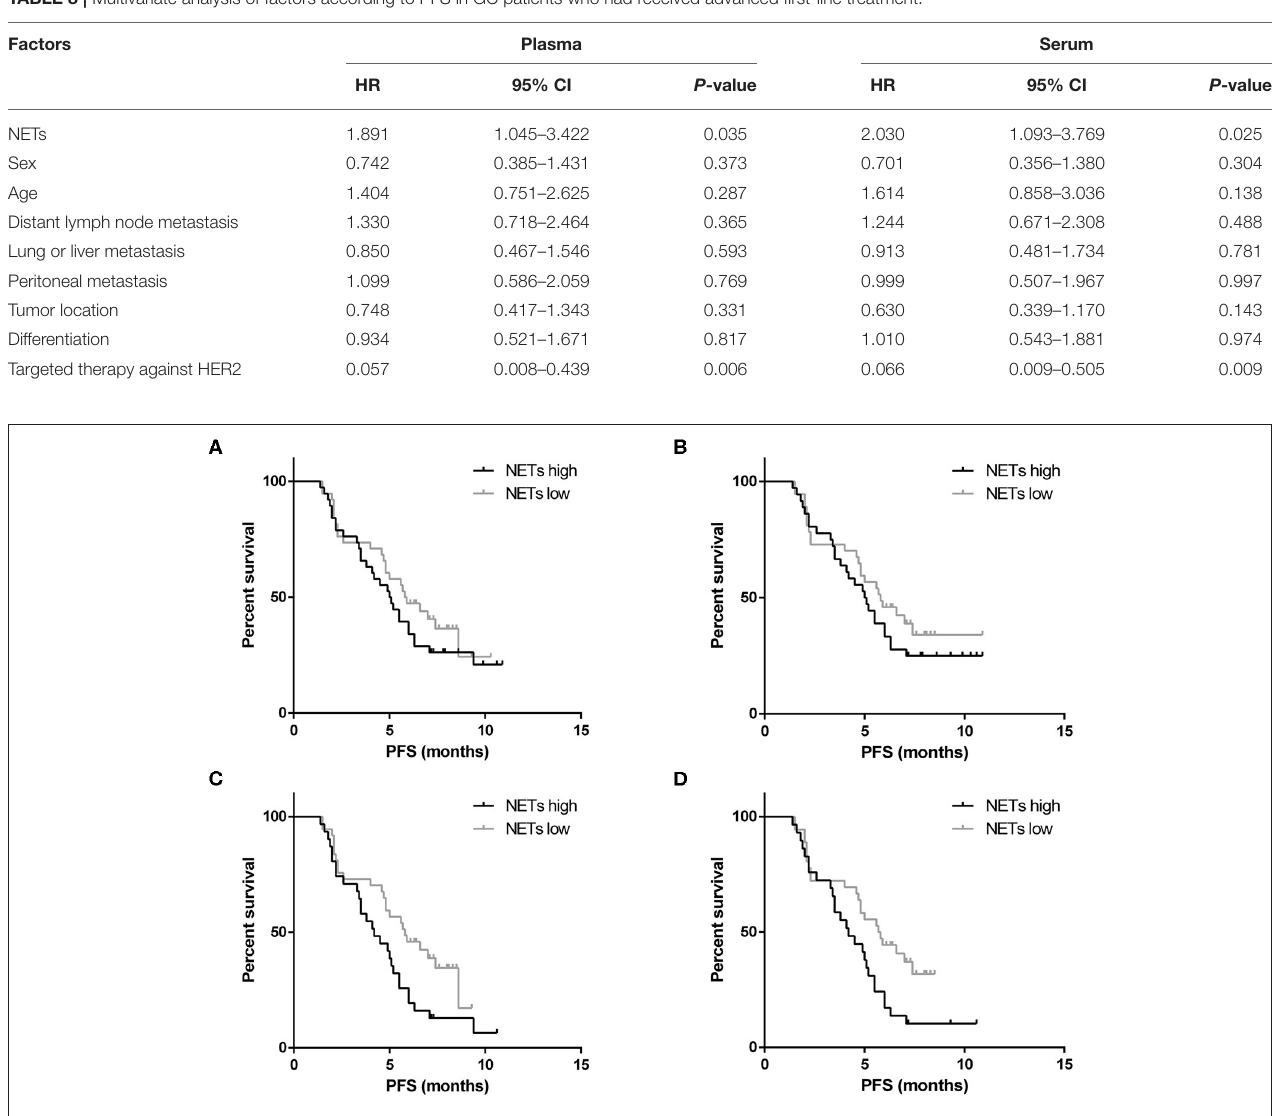
FIGURE 6 | Survival analysis for neutrophil extracellular traps (NETs). There was no correlation between the baseline levels of NETs in the plasma (A) or serum (B) and the progression-free survival (PFS) of patients with gastric cancer (GC) who had received advanced first-line treatment. In the subgroup analysis, the higher baseline level of NETs in the plasma (C) or serum (D) of patients with negative HER2 status was correlated with worse